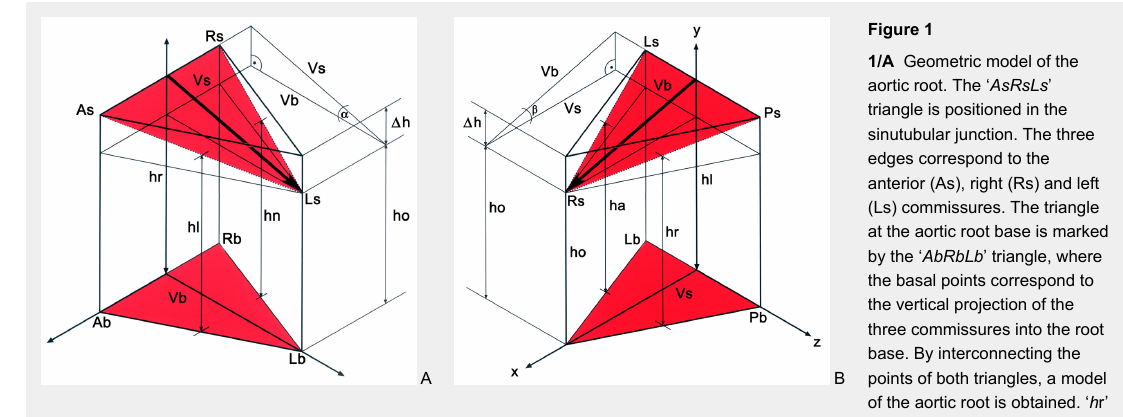
corresponds to the height measured in the right sinus; ‘ h l’ and ‘ h n’ to the heights obtained in the left and non-coronary sinuses, respectively. ‘ h o’ is the distance between the ‘ Ls’ and ‘ Lb’ respectively. ‘∆ h’ is calculated as the difference between ‘ hr ’ and ‘ h o’. The ‘ Vs ’ height of the ‘ AsRsLs ’ triangle also was calculated. One can observe that the tilt angle between the basal and sinutubular triangles corresponds to the ‘α’ angle in the triangle, which is defined by ‘∆ h’ and ‘ Vs ’. The ‘α’ angle is calculated according to the rules of a right-angle triangle. The tilt angle of the aortic root is 5.47° 1/B Geometric model of the pulmonary root. The ‘ PsLsRs’ triangle is found at the level of the sinutubular junction and is defined by the posterior (Ps), left (Rs) and right (Rs) commissures. The triangle at the aortic root base is marked by the ‘ PbLbRb’ triangle, where the basal points correspond to projection of the commissures onto the inter-valvular triangles. By interconnecting the mentioned points, a 3-D model of the pulmonary root is obtained. ‘ h l’ corresponds to the height measured in the left sinus; ‘ h a’ and ‘ h r’ to the heights obtained in the anterior and in the right pulmonary sinuses, respectively. ‘ h o’ is the distance between ‘ Rs’ and ‘ Rb’ . ‘∆ h ’ is calculated as the difference between ‘ hl ’ and ‘ h o’. ‘ Vs ’ is the height of the ‘ PsLsRs ’ triangle, which also was calculated. One can observe that the tilt angle between the basal and sinutubular triangles corresponds to the ‘ β’ angle in the triangle, which is defined by ‘∆ h’ and ‘ Vs ’. The ‘ β ’ angle is calculated according to the rules of a right-angle triangle. The tilt angle of the pulmonary root is